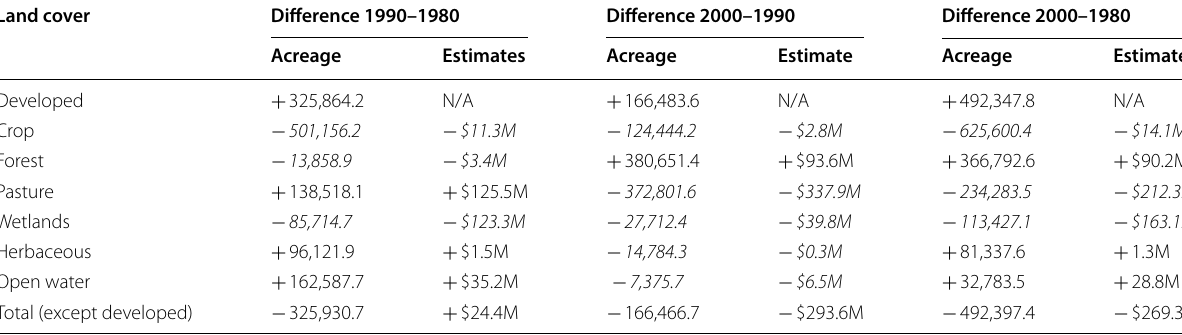
Table 5 Acreage and costs difference between 1980 and 2000 Land